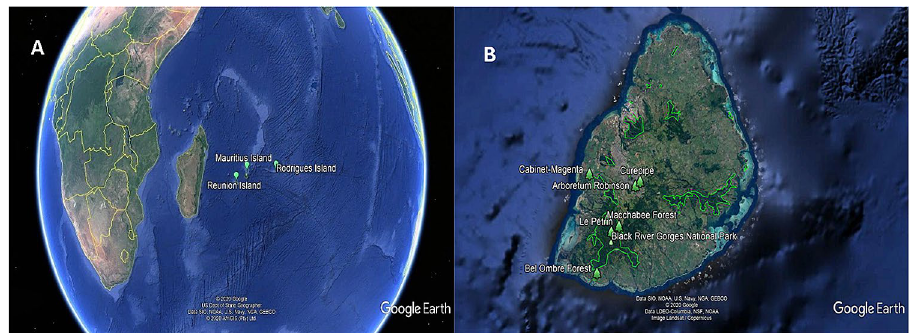
Figure 1. ( A ) Location of Mauritius and the Mascarenes Islands in the Indian Ocean. ( B ) Collection site of endemic plants across the island of